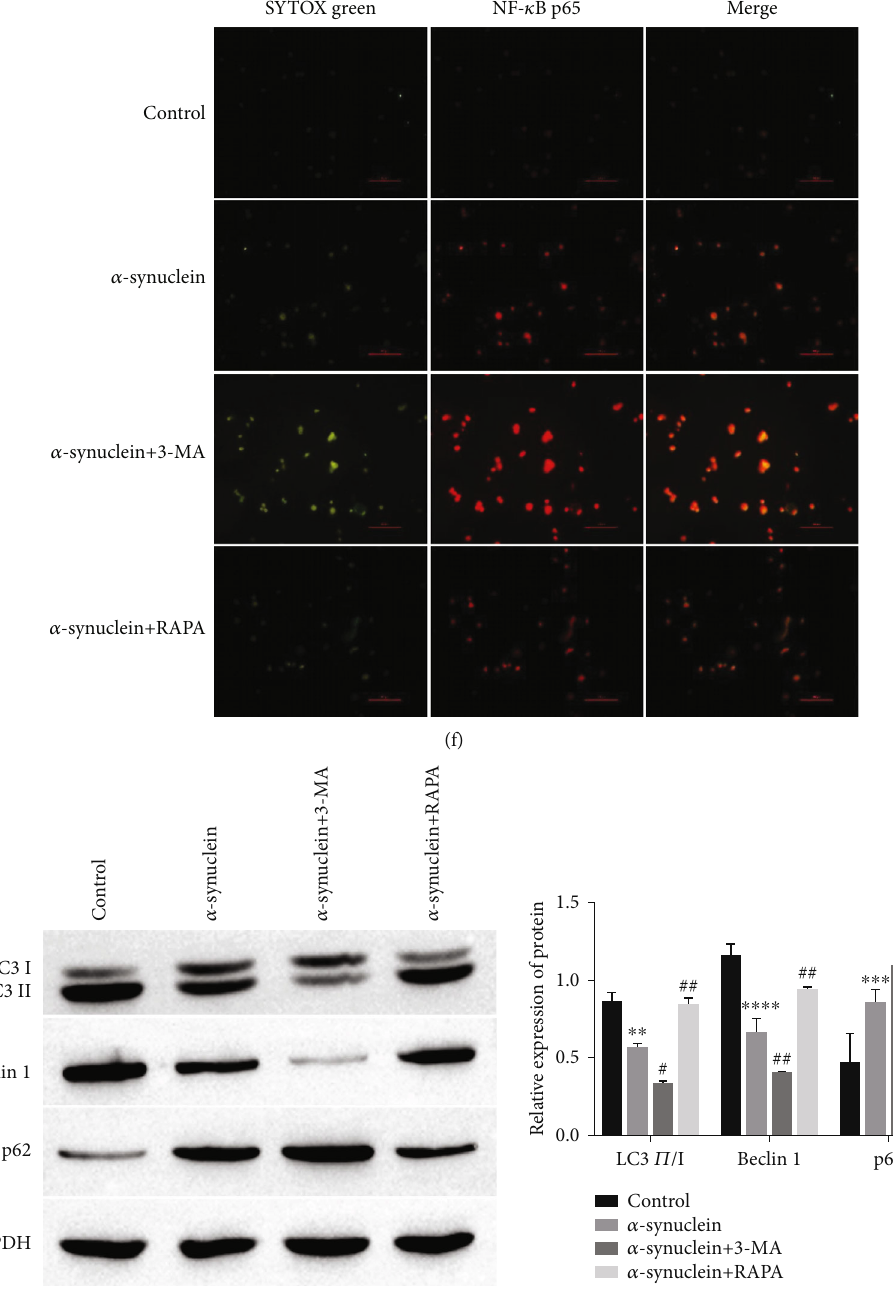
Figure 5: α -Synuclein a ff ects microglial activation by mediating autophagy. (a) The level of MIP-1 α was detected by ELISA, ∗∗∗∗ P < 0 : 0001 vs. control and #### P < 0 : 0001 vs. α -synuclein. (b) The level of TNF- α was detected by ELISA, ∗∗∗∗ P < 0 : 0001 vs. control and #### P < 0 : 0001 vs. α -synuclein. (c) The level of IL-1 β was detected by ELISA, ∗∗∗∗ P < 0 : 0001 vs. control and #### P < 0 : 0001 vs. α -synuclein. (d) The level of IL-6 was detected by ELISA, ∗∗∗∗ P < 0 : 0001 vs. control and #### P < 0 : 0001 vs. α -synuclein. (e) The level of INF- γ was detected by ELISA, ∗∗∗∗ P < 0 : 0001 vs. control and #### P < 0 : 0001 vs. α -synuclein. (f) NF- κ B p65 nuclear translocation assay, scale bar = 100 px. (g) The expressions of LC3 II/I, Beclin 1, and p62 were detected by western blot, ∗∗ P < 0 : 01 , ∗∗∗ P < 0 : 001 , and ∗∗∗∗ P < 0 : 0001 vs. control, # P < 0 : 05 , ## P < 0 : 01 vs. α